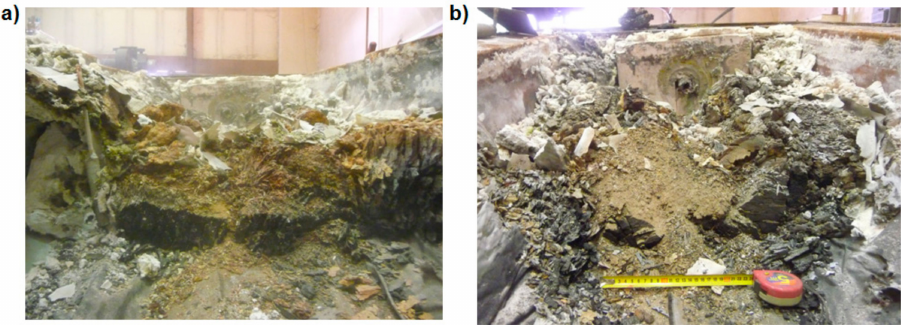
Figure 7. The unburned layer of coal ( a ) in the second meter, ( b ) in the third meter (Source: own